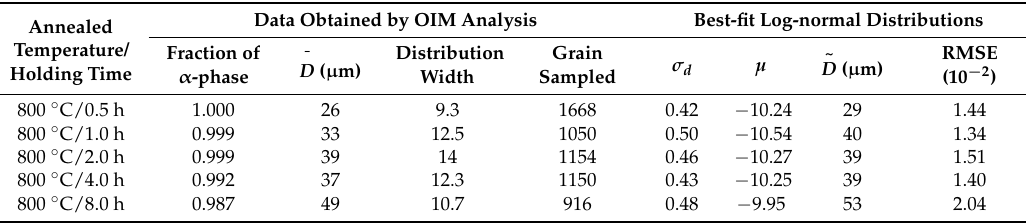
Figure 4. Grain size distributions determined from optical micrographs by EBSD investigations for specimens annealed at 800 °C holding for ( a ) 0.5 h, ( b ) 1 h, ( c ) 2 h, ( d ) 4 h, and ( e ) 8 h presented as blue histograms, with fitted curves for log ‐ normal size distribution superposed in solid lines. (Color online). Table 1. Microstructure data obtained from the EBSD investigation and the parameters for the fitted model of log ‐ normal size distribution.